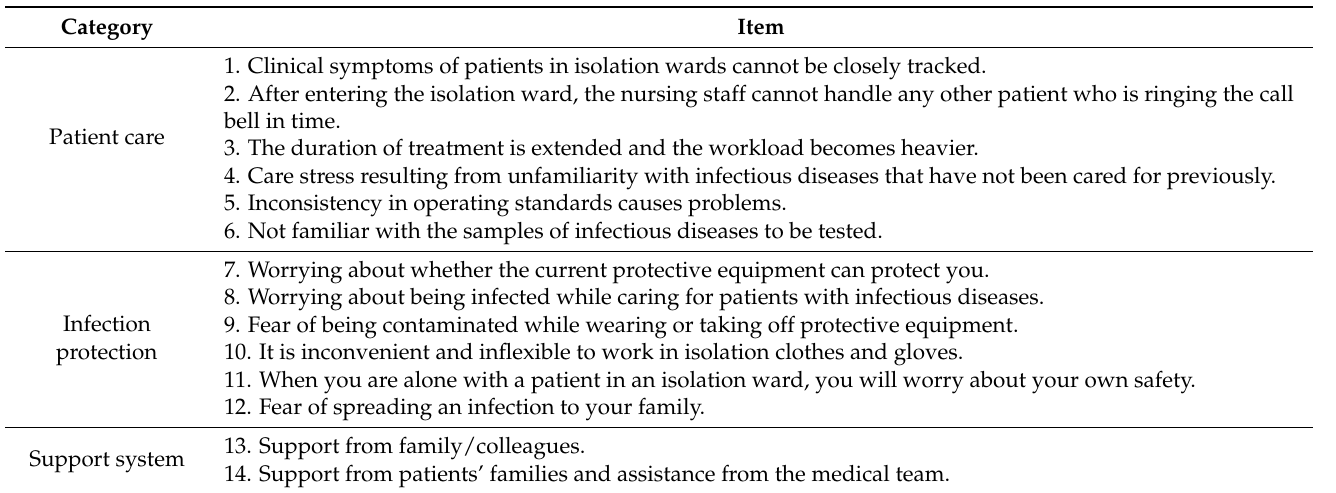
Table 1. Evaluation of the care stress attributes of infectious